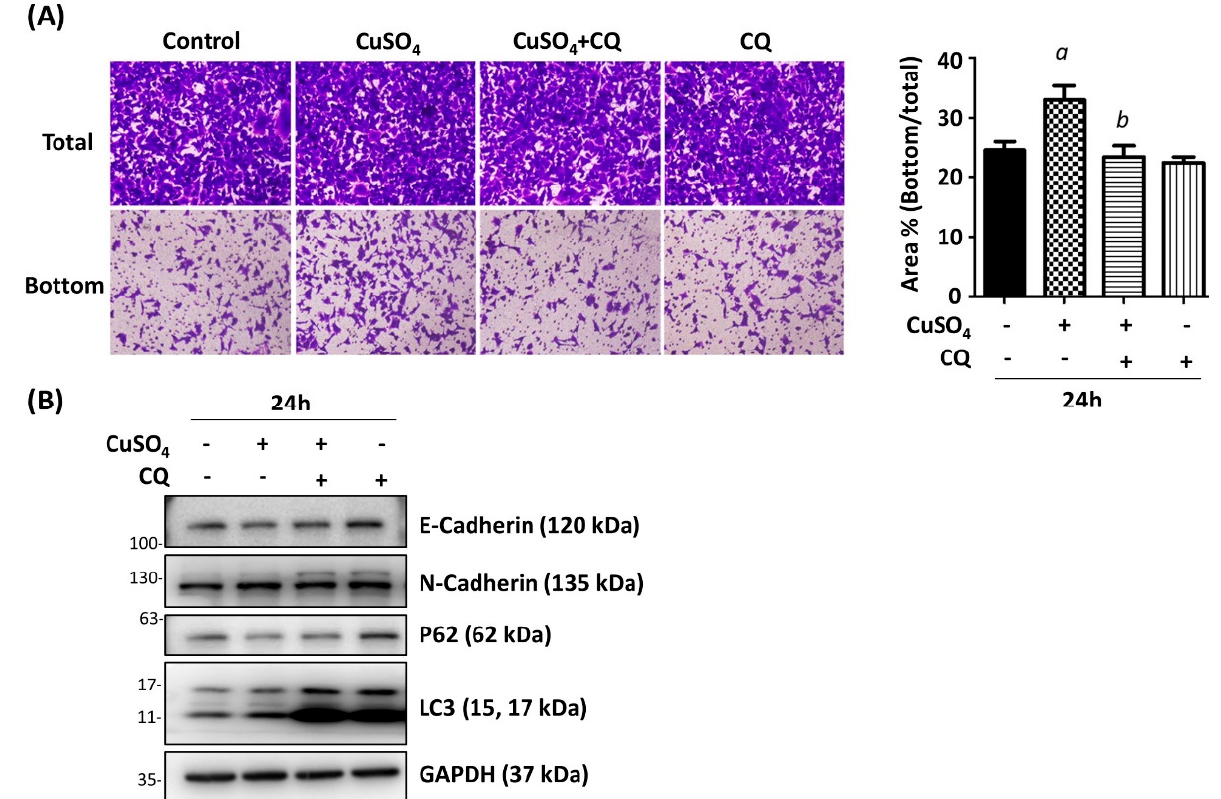
CQ inhibit the cell migration induced by CuSO 4 (Figure 4A). Moreover, the EMT marker expressions were determined by immunoblot. The results demonstrated that the autophagy was significantly blocked by CQ treatment as shown by the accumulated LC3II expression (Figure 4B). The decrease of E-Cadherin and the increase of N-Cadherin were reversed by the inhibition of autophagy (Figure 4B). These results indicate that the copper-induced EMT of A549 cells is mediated, at least partially, by the induction of autophagy.